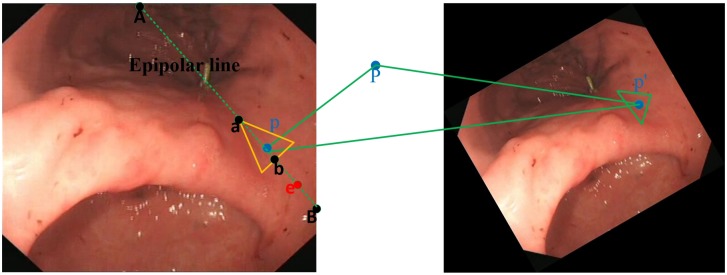
The search line (from a to b in the left image) determined by epipolar constraint and homographic constraint.